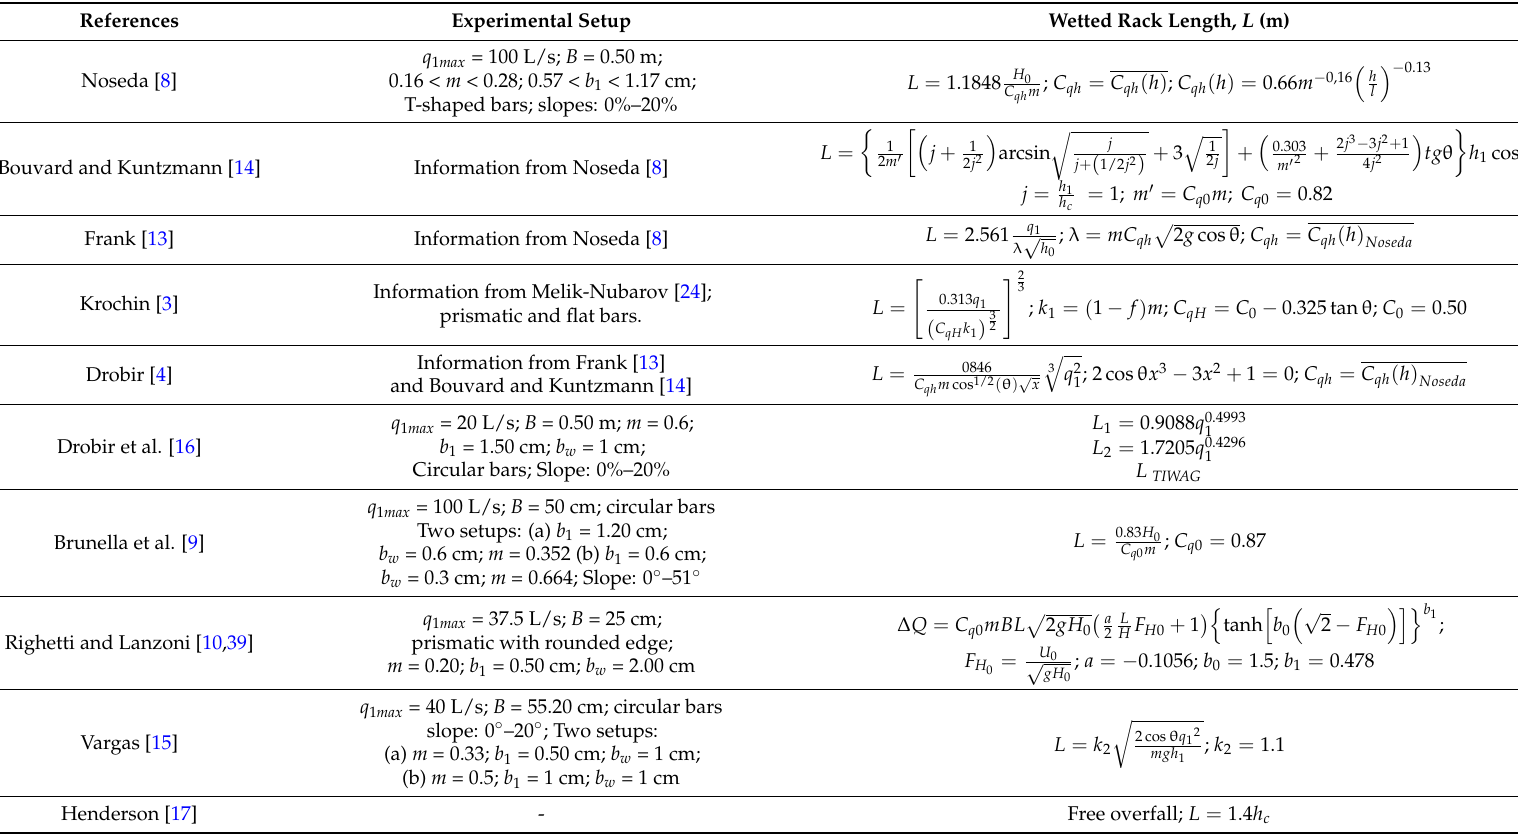
Table A1. Summary of wetted rack lengths to derive an approaching flow proposed in the